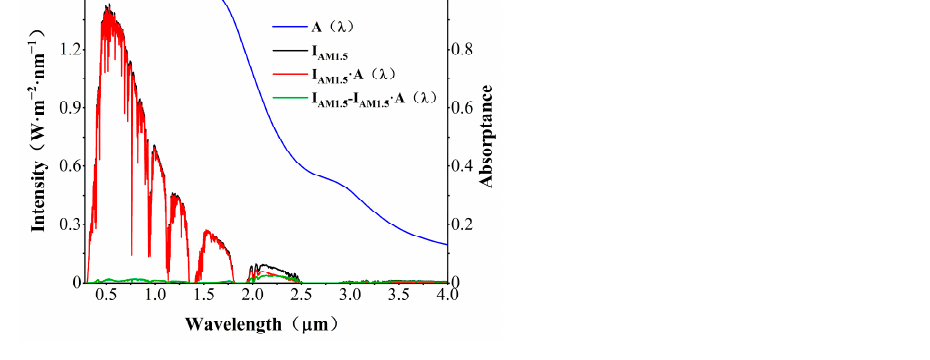
Figure 3. Solar spectral irradiance AM 1.5 of global tilt, absorption spectrum of proposed meta- structure solar absorber and residual solar irradiance in the ultraviolet, visible and near-infrared regions (0.28–4 μ m).